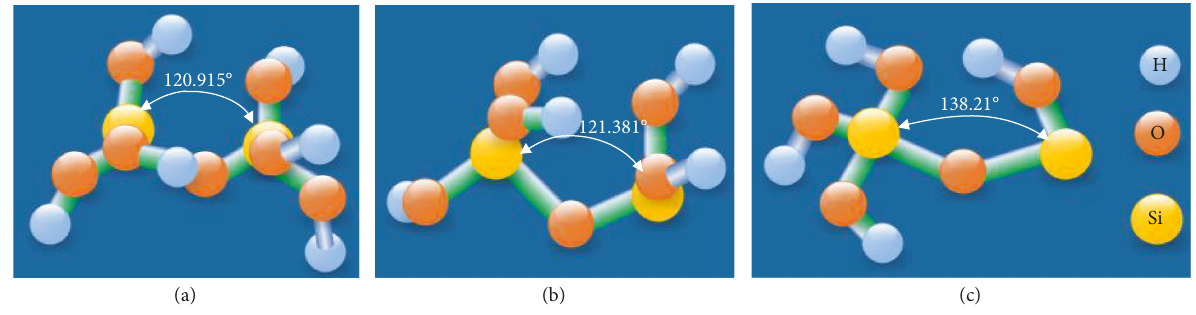
Figure 16: MD calculation results for different structures. (a) (OH) 3 Si-O-Si(OH) 3 . (b) (OH) 3 Si-O-Si(OH) 2 . (c) (OH) 3 Si-O-Si(OH) 1